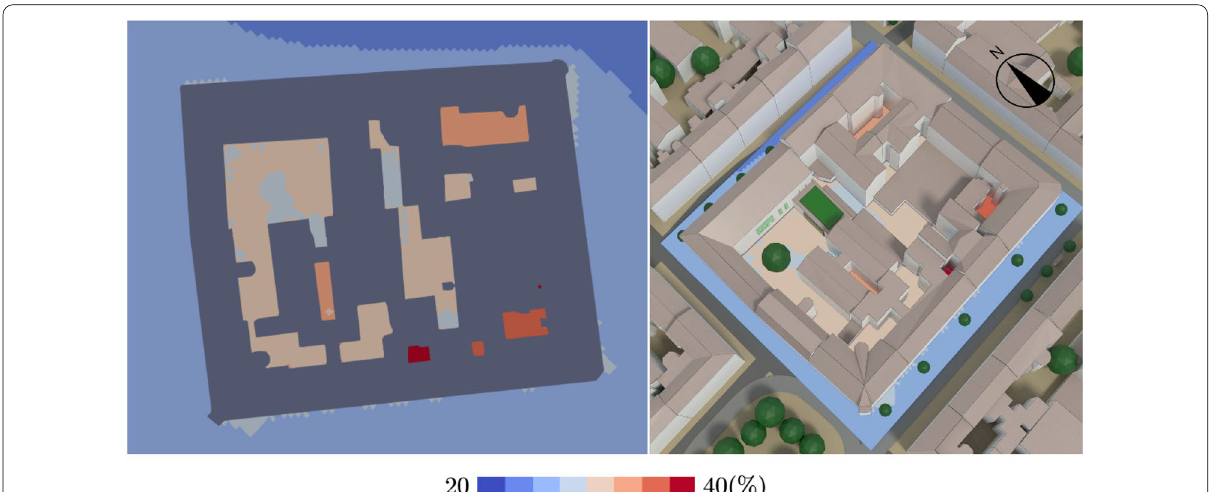
Fig. 18 Relative humidity of the simulation case Kandlgasse, 1.5 m above the ground at 14:00 CEST on 01 August 2017